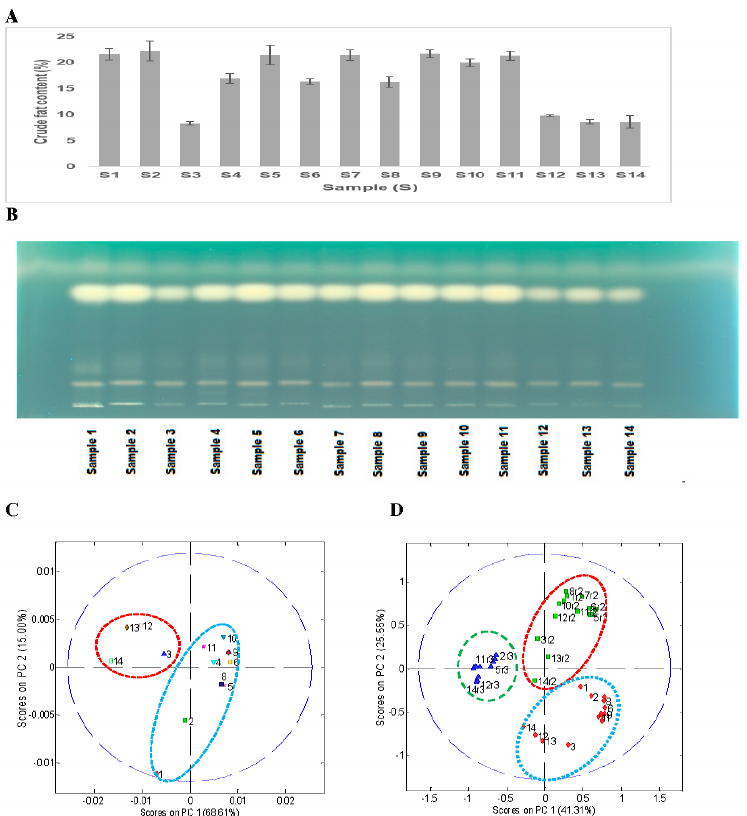
Figure 2. ( A ) Total crude fat content, ( B ) high-performance thin layer chromatography (HPTLC) analysis of the crude fat hexane extract form 14 soybean samples, ( C ) a typical principal component analysis (PCA) analysis score plot of hexane extract HPTLC data from a single repetition, and ( D ) PCA analysis score plot of the HPTLC data of 14 soybean hexane extracts from all three repetitions (r1 red, r2 green, and r3 blue) analyzed on separate HPTLC